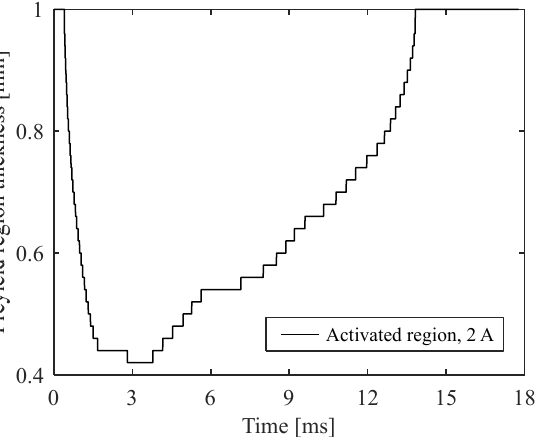
Figure 20. Dynamic variation of the pre-yield region thickness for the 2 A excitation current.